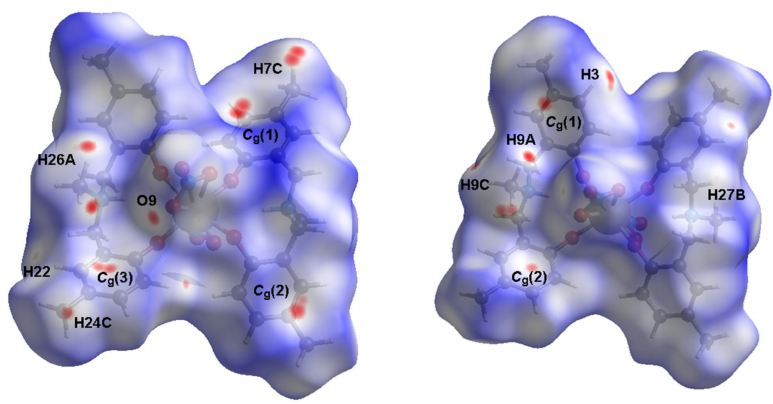
Figure 6. Two Hirshfeld surfaces viewing on the opposite sides mapped over d norm in the range from − 0.1157 to +1.5886 arbitrary units.